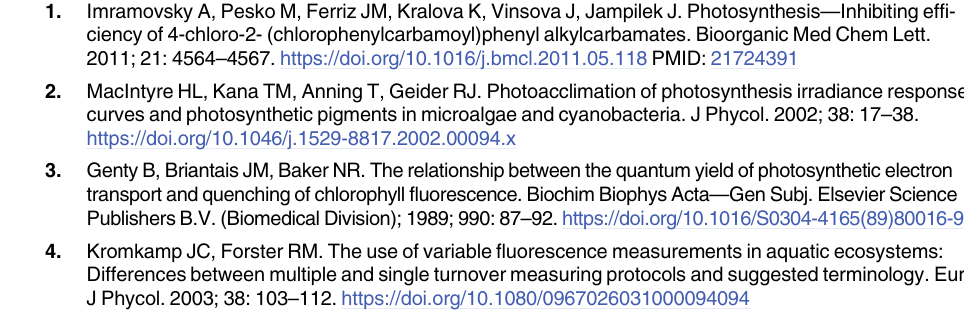
S2 Fig. Simultaneous measurement of oxygen evolution (A) and carbon uptake (B) for 5 sam- ples with different Chla concentrations. (TIFF) S3 Fig. Dynamic changes of carbon uptake and oxygen evolution quantum yield as a func- tion of instantaneous irradiance during the 24 hours high light acclimation. (TIFF) S1 Text. Measuring dissolved CO2 vs. measuring pH. (DOCX) S2 Text. Parameters for A calculation. C (DOCX) S3 Text. Nernst equation validation. (DOCX) S4 Text. Equations for computing saturation oxygen concentration.